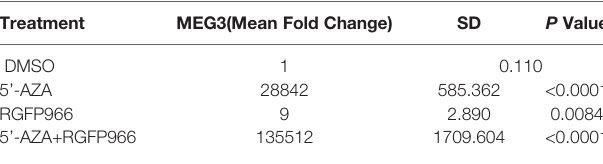
TABLE 1 | Induction of MEG3 expression by 5 ’ -AZA and RGFP966.